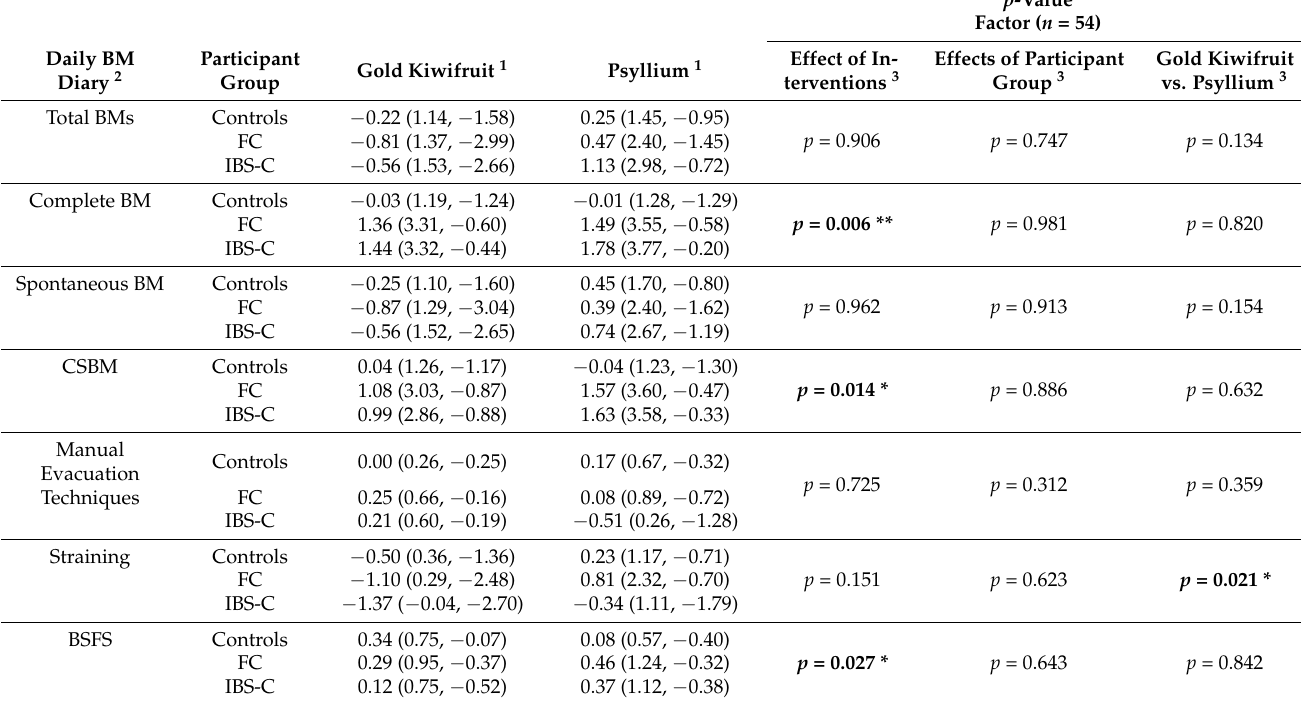
represent statistical significance. 2 Values scored using actual number of BM, “Yes/No” for complete, spontaneous, laxative use, manual evacuation method and straining for every BM. BSFS was rated from 1 to 7: “Separate hard lumps, like nuts (hard to pass)”, “Sausage shaped but lumpy”, “Like a sausage but with cracks on its surface”, “Like a sausage or snake, smooth and soft”, “softs blobs with clear-cut edges (passed easily)”, “Fluffy pieces with ragged edges, a mushy stool” and “watery, no solid pieces”. 3 Combined effect of interventions on the relative shift from baseline. Effects of participant group on the relative shift from baseline. Kiwifruit vs. psyllium = differences between the interventions on their effect on the relative shift. Bold indicates statistical significance. * p < 0.05. BM, ** p < 0.01. Bowel Movement; CSBM, Complete Spontaneous Bowel Movement; BSFS, Bristol Stool Form